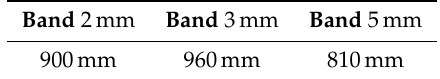
Table 4. The maximum stretch length electro-resistive bands (ERBs) can handle before entering the fracture length starting initially from